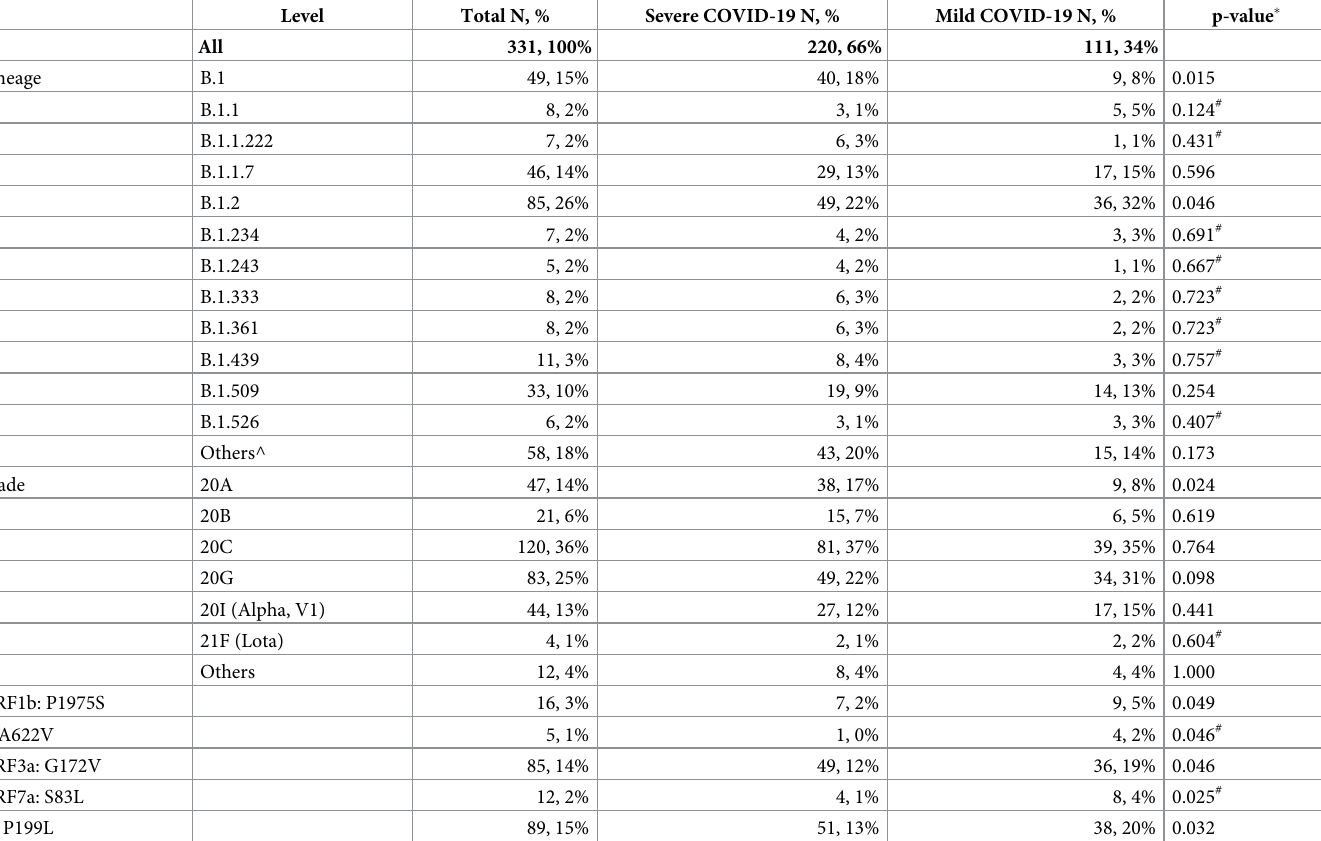
Table 2. Summary of SARS-CoV-2 lineages, clades, and individual mutations (gene) of UPMC COVID-19